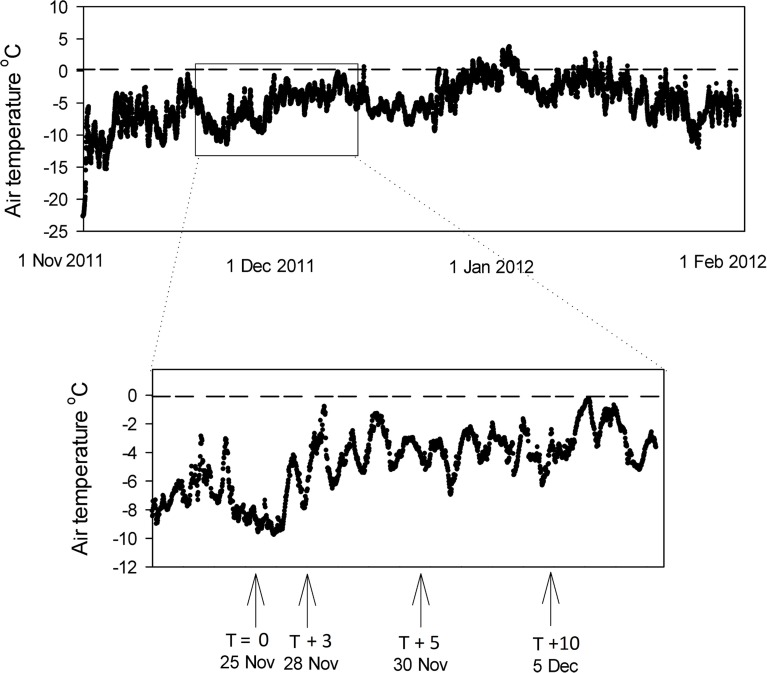
Air temperature record for the surface of Canada Glacier during the 2011 season. Data from Fountain, www.mcmlter.org/queries/met/met_stations.jsp#CAAM. Inset shows ice core and cryoconite hole sampling points.